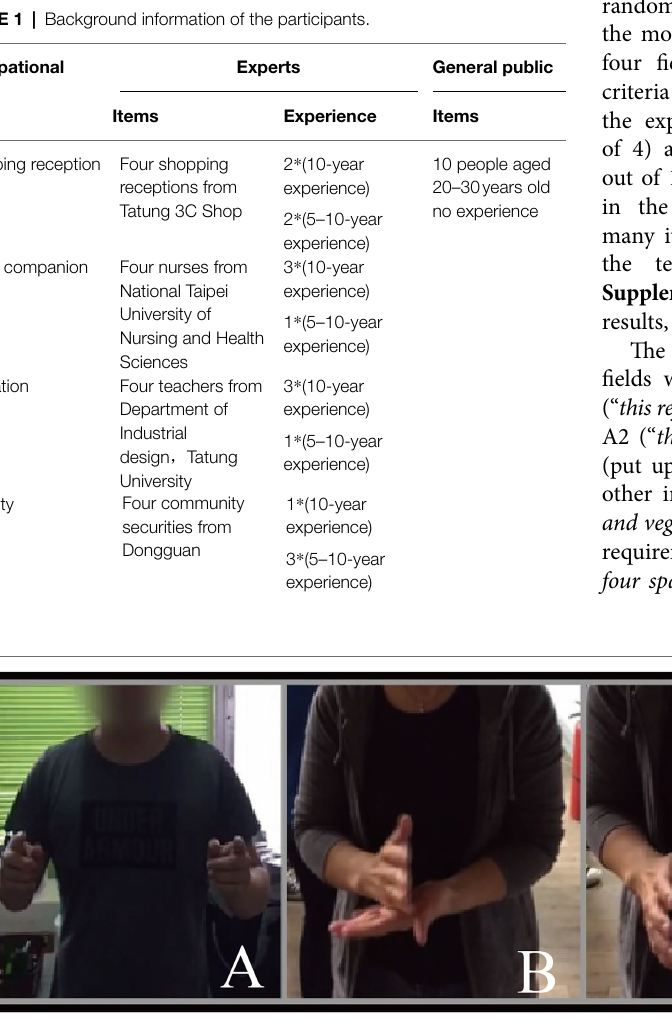
FIGURE 2 | Selected screenshots from the observation ( A : longer segment, B : chop into pieces, C : washing, D : titling head).